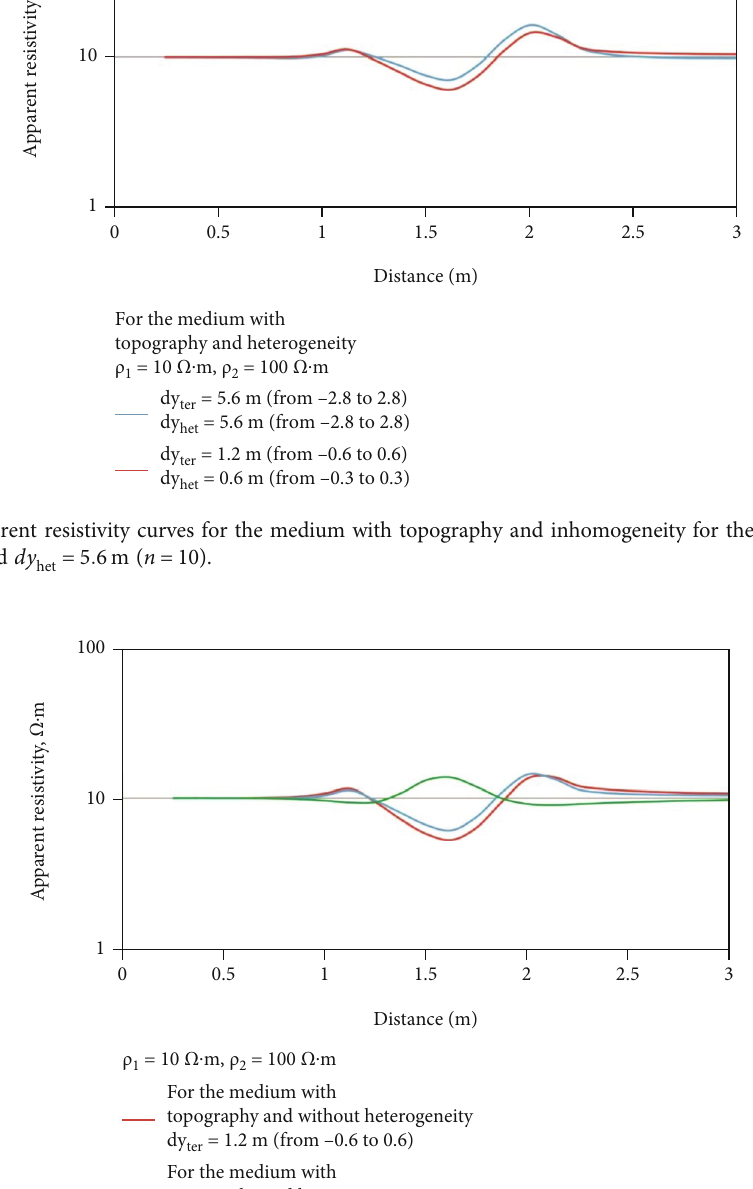
Figure 16: Comparative graph of apparent resistivity curves ( ρ